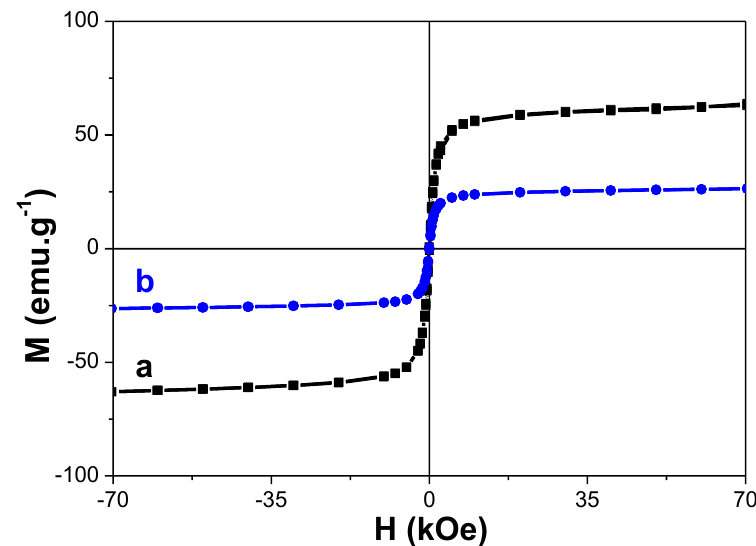
Figure 5. Variation of the magnetization as function of the magnetic field M ( H ) measured at T = 310 K of ( a ) γ -Fe 2 O 3 and ( b ) β -NaY 0.8 Eu 0.2 F 4 @ γ -Fe 2 O 3 particles.